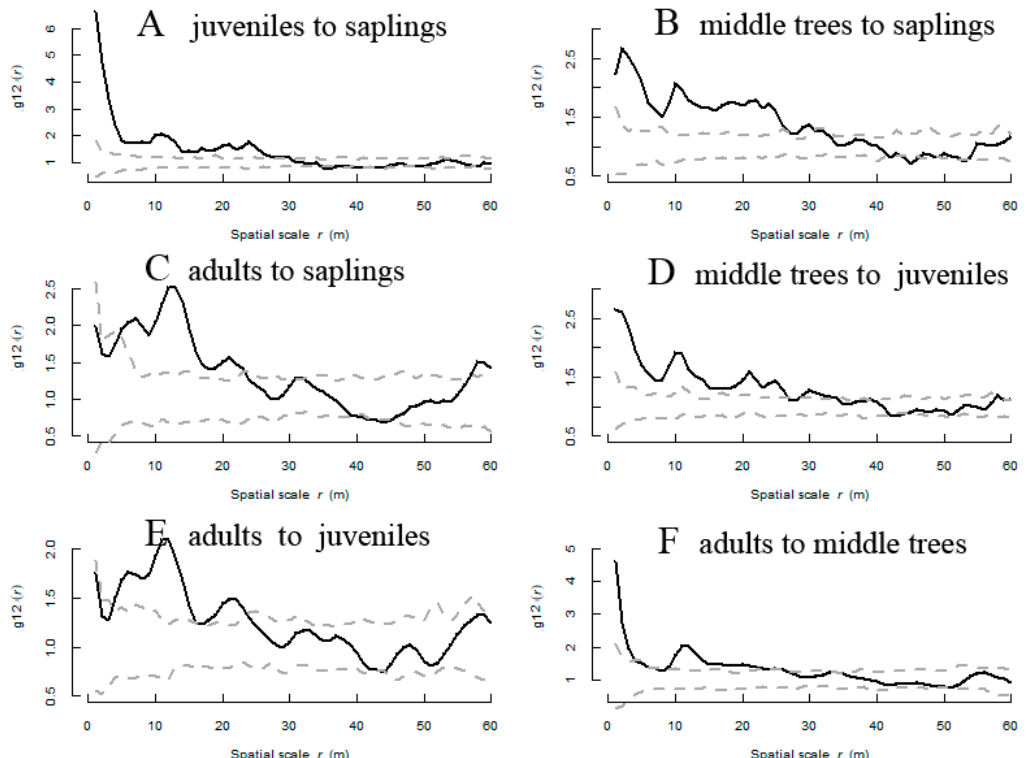
Figure 4. Spatial associations of Carpinus tientaiensis among different DBH classes in the Carpinus tientaiensis sampling plot. Note: The insertions at figure a indicate the point patterns analysis of three size classes (saplings as 1 cm ≤ DBH < 5 cm, juveniles as 5 cm ≤ DBH < 10 cm, middle trees as 10 cm ≤ DHB < 20 cm and adults as DBH ≥ 15 cm). Black lines indicate g 12 (r) function, dotted lines indicate the upper and lower limits of the 99% confidence interval. Observed value above the upper limits indicate positive association, within the intervals indicate no association, and below the lower limits indicate negative association.